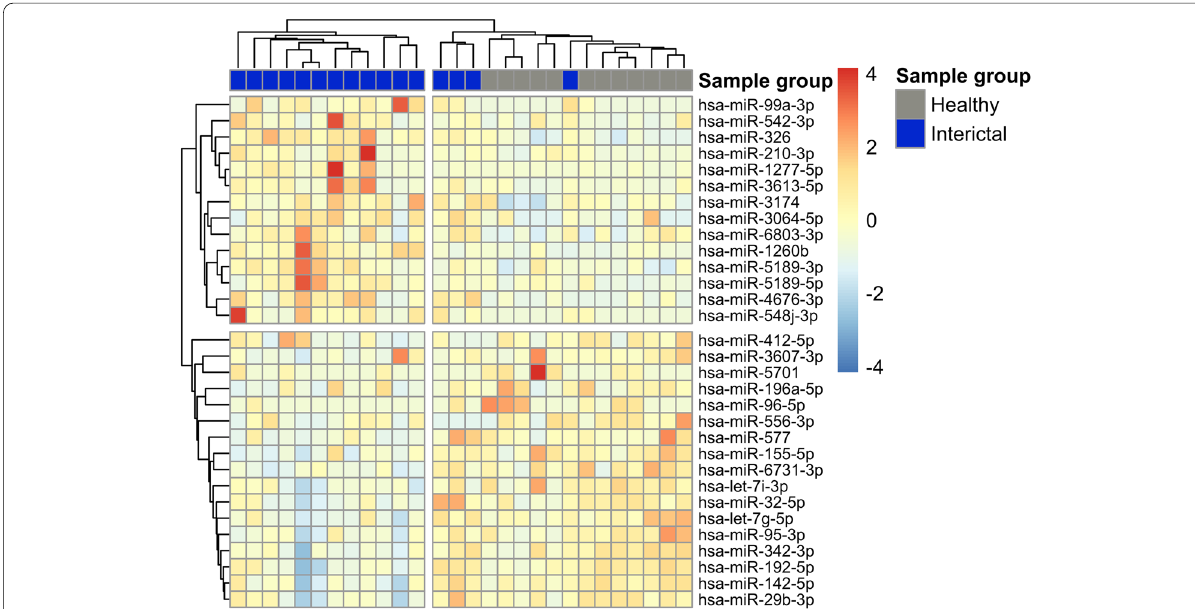
Fig. 1 Heat map representation of differentially expressed genes in the interictal vs healthy PBMC comparison. Columns represent samples, and rows represent genes. Pearson correlation was respectively calculated between samples and genes, visualised by dendrograms